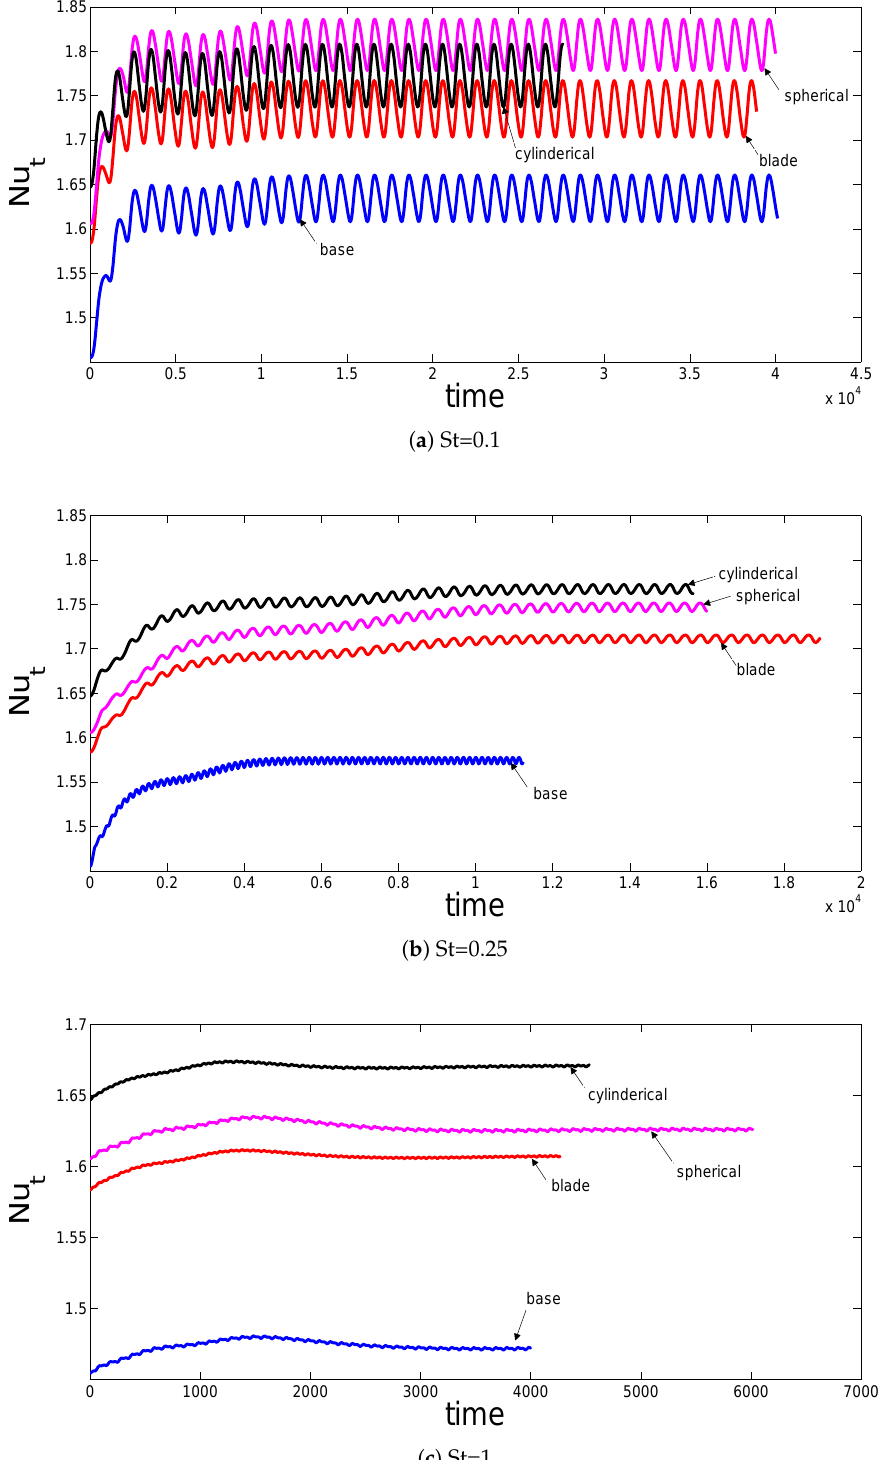
Figure 8. Effects of particle shape on the spatially-average Nusselt number along the hot wall for various pulsating